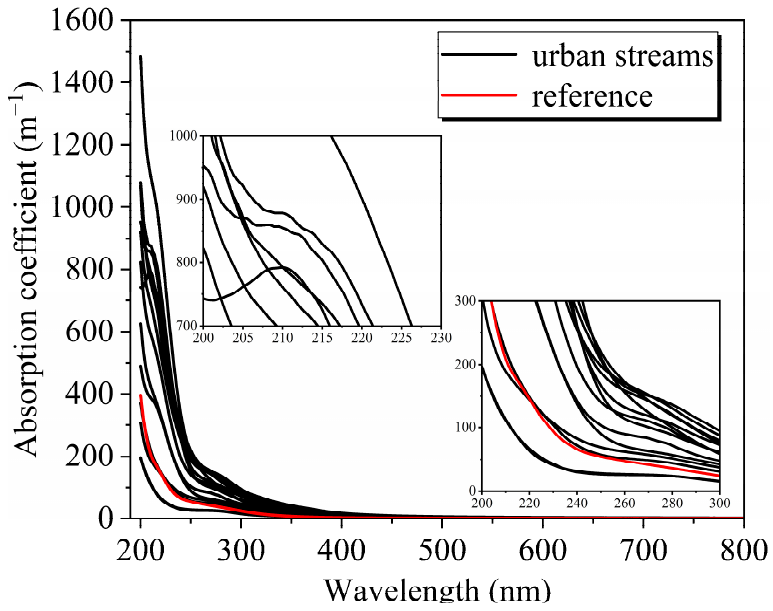
Figure 3. UV-Vis absorption spectra of CDOM in sediments from urban streams and the reference, with special curves in the upper left and lower right corner.